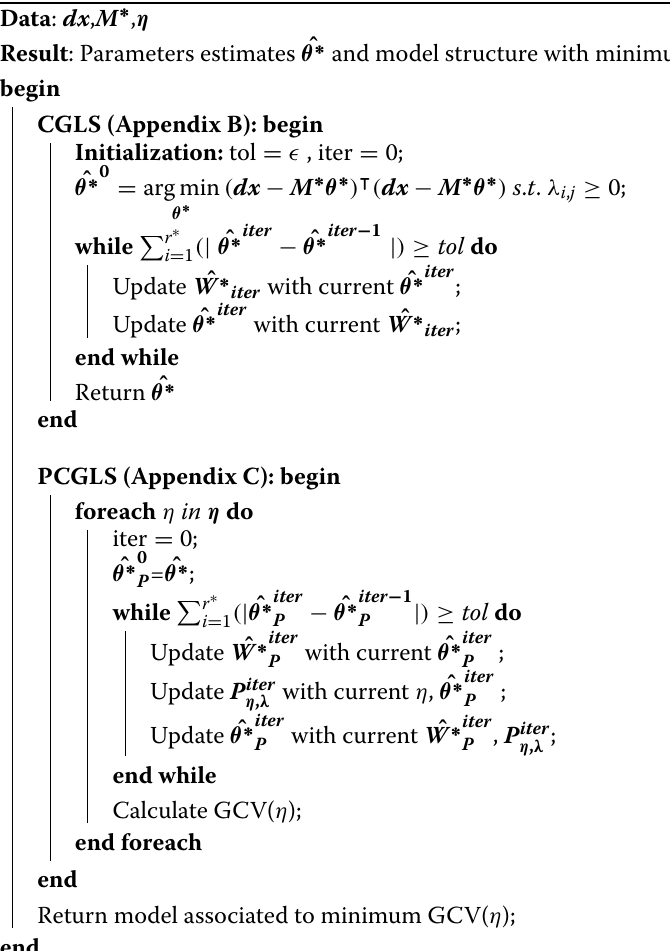
Algorithm 1: Structure of the proposed inferential procedure composed by CGLS and